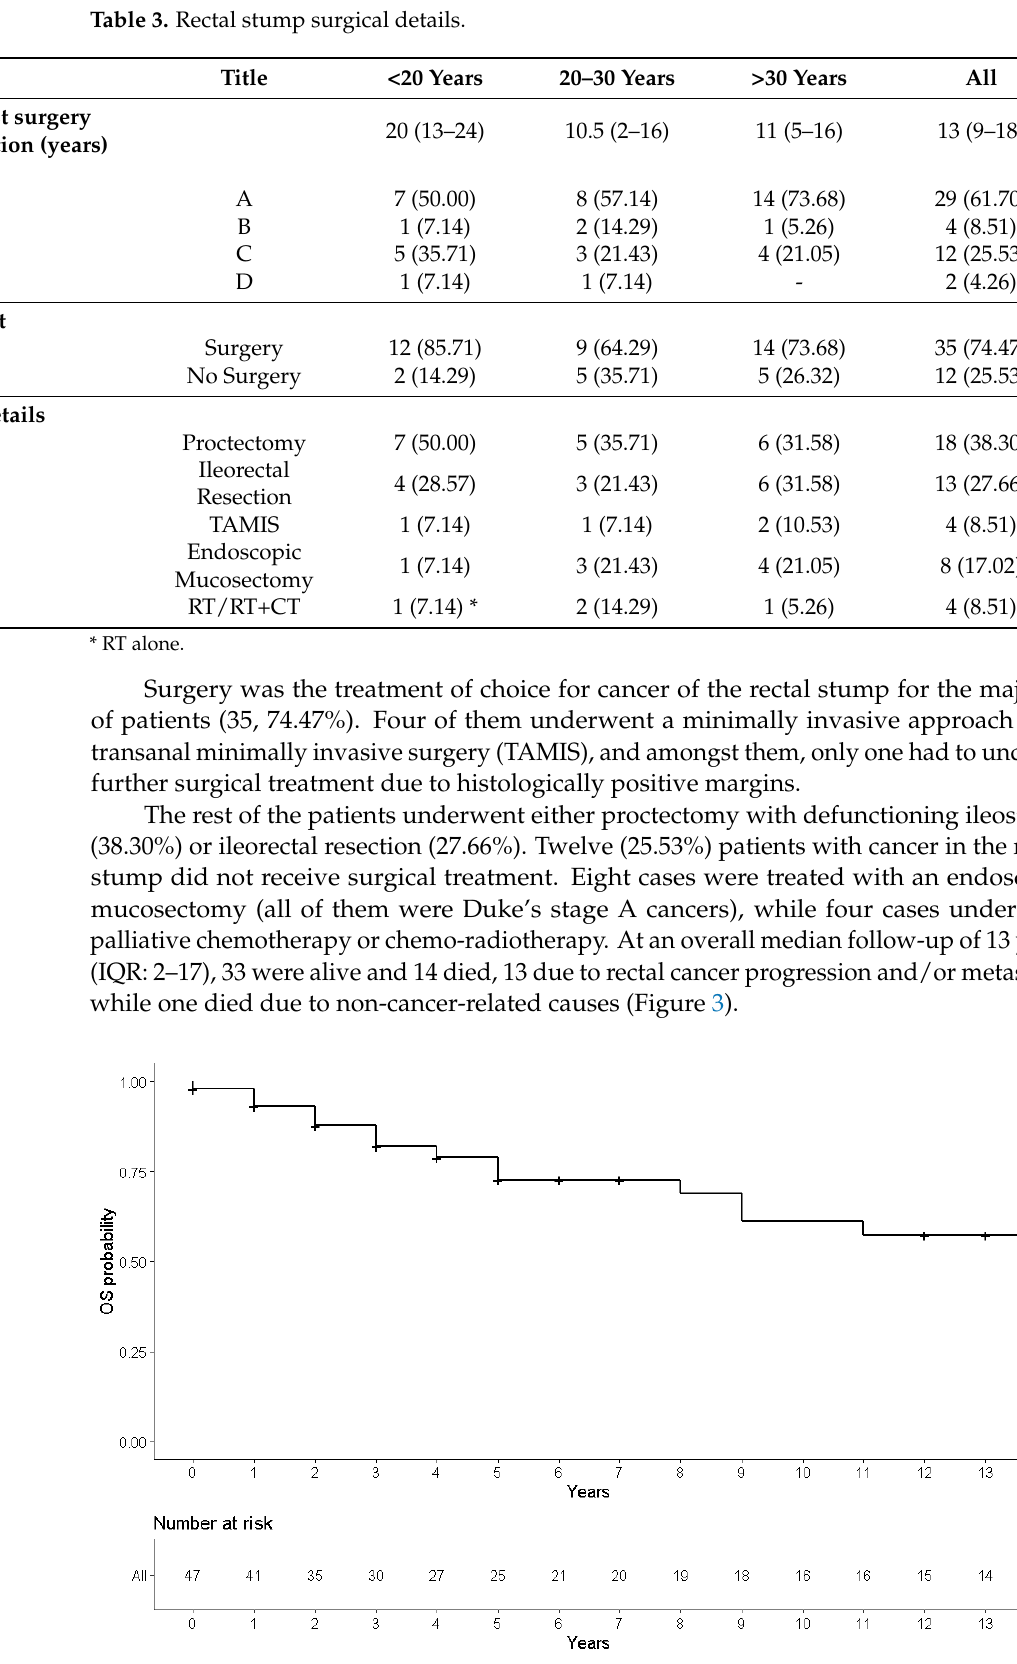
Figure 3. Thirteen ‐ year OS probability in FAP patients from rectal cancer treatment. Figure 3. Thirteen-year OS probability in FAP patients from rectal cancer